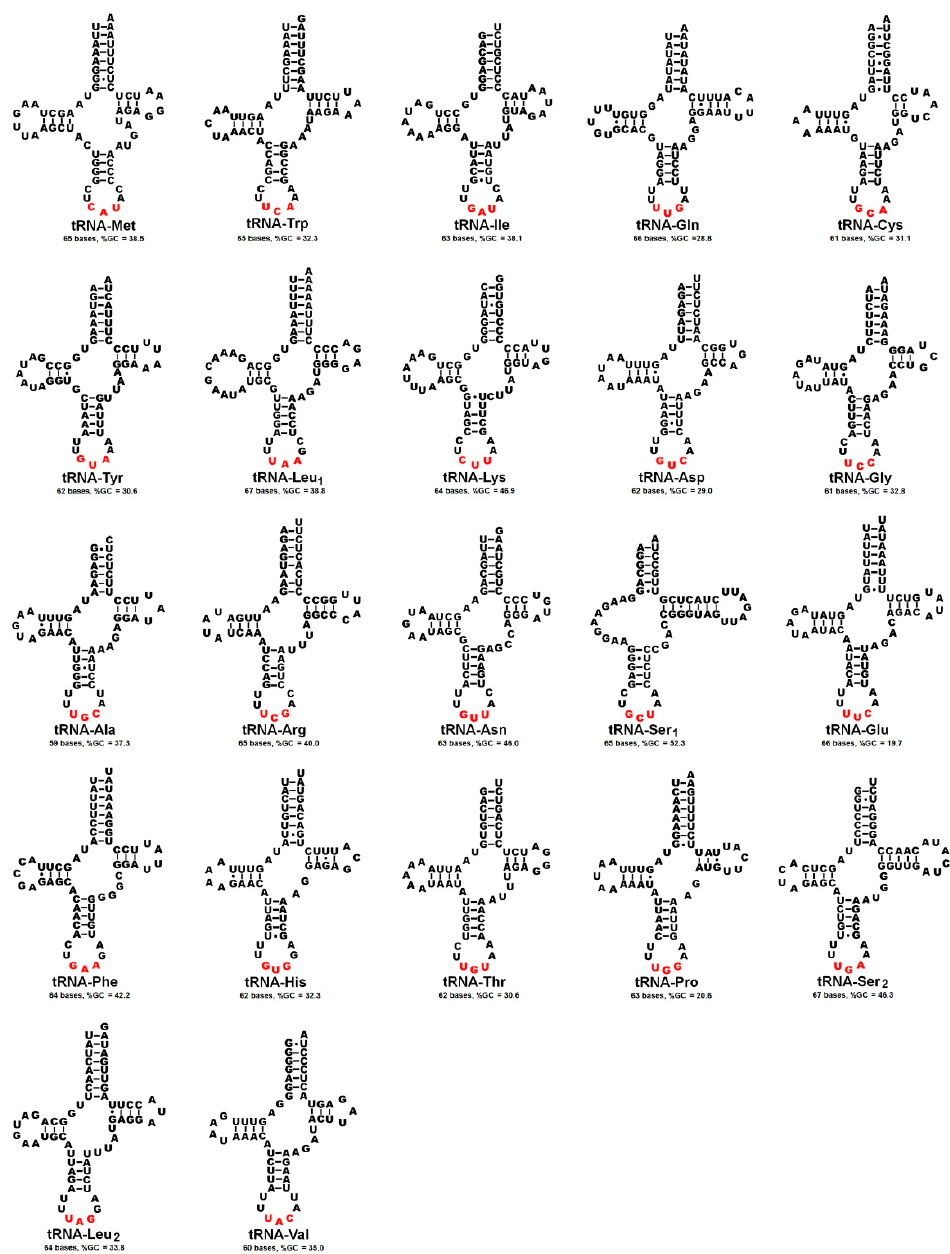
Figure 3. Putative secondary structures of mitochondrial tRNAs determined in A. urmiana . Nucleotides in red color indicate anticodon sequences.